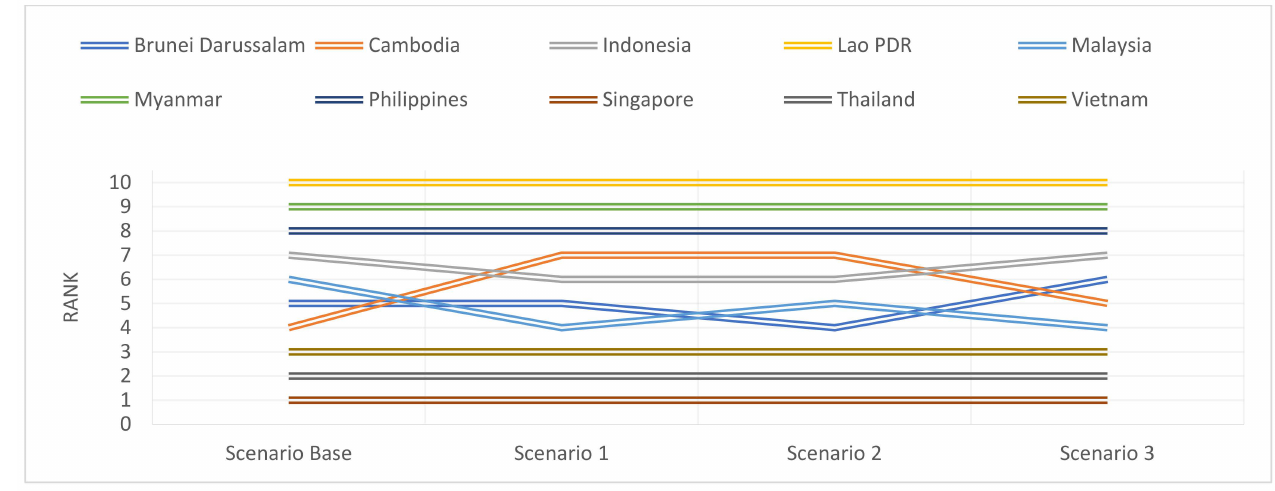
Figure 6. Indicator weighting scenarios.